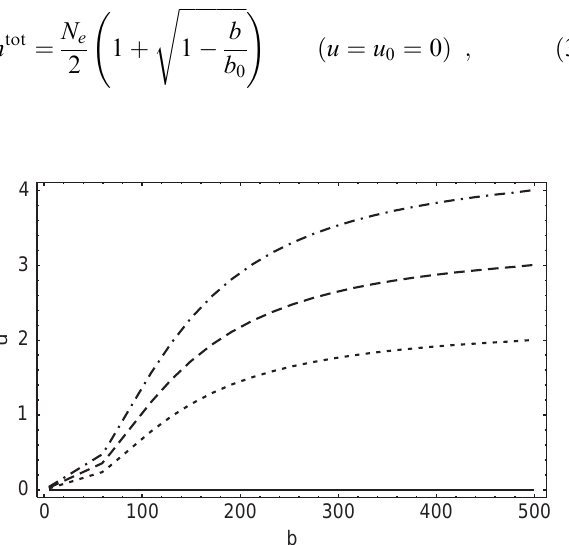
Fig. 4. Same as Fig. 3 but for the pressure (Eq. 27)